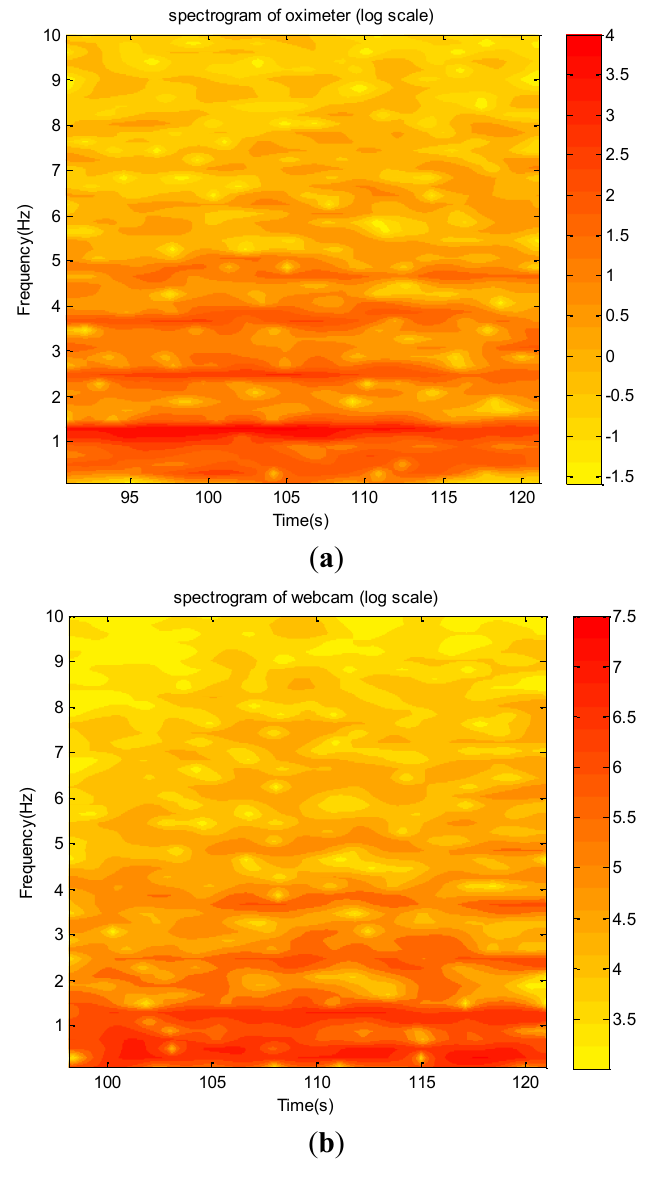
Figure 20. The wavelet coefficient plots of the neck arterial pressure signal of an healthy adult: ( a ) the level of the blood-oxygen saturation captured by the pulse oximeter. ( b ) captured by the